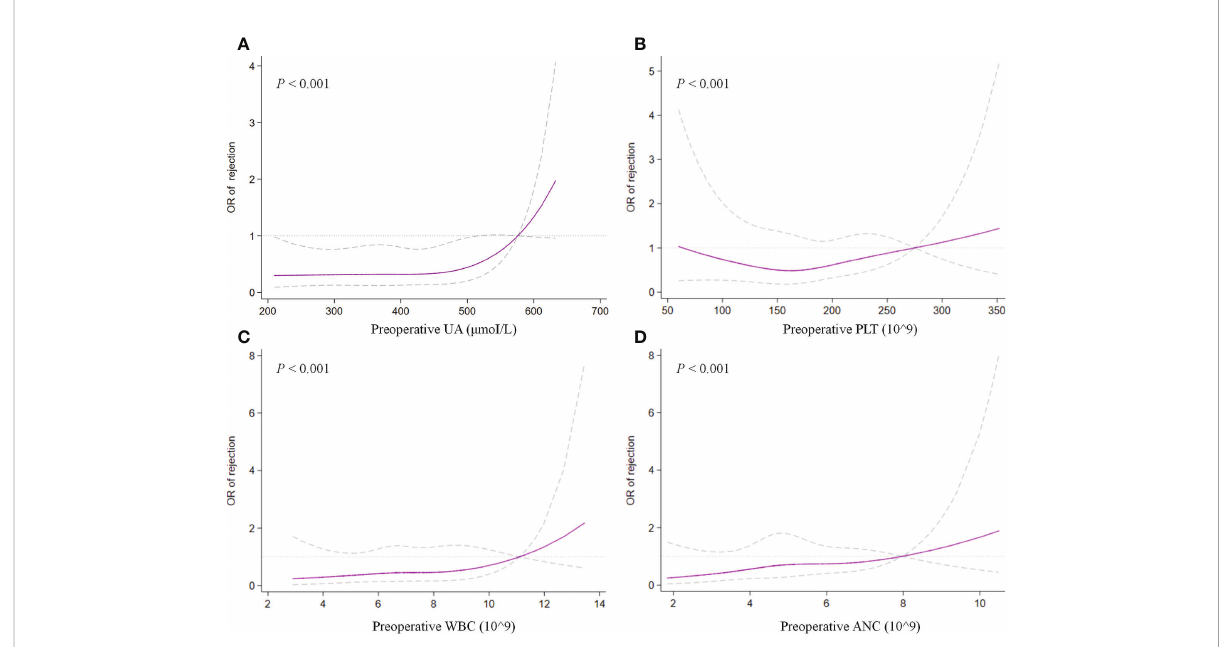
FIGURE 2 Restricted cubic splines examined the association of preoperative UA (A) , PLT (B) , WBC (C) , and ANC (D) with treated rejection. UA, uric acid; PLT, platelet; WBC, white blood cell; ANC, absolute neutrophil